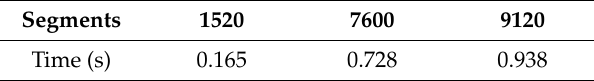
Table 10. Recognition time of different segments.